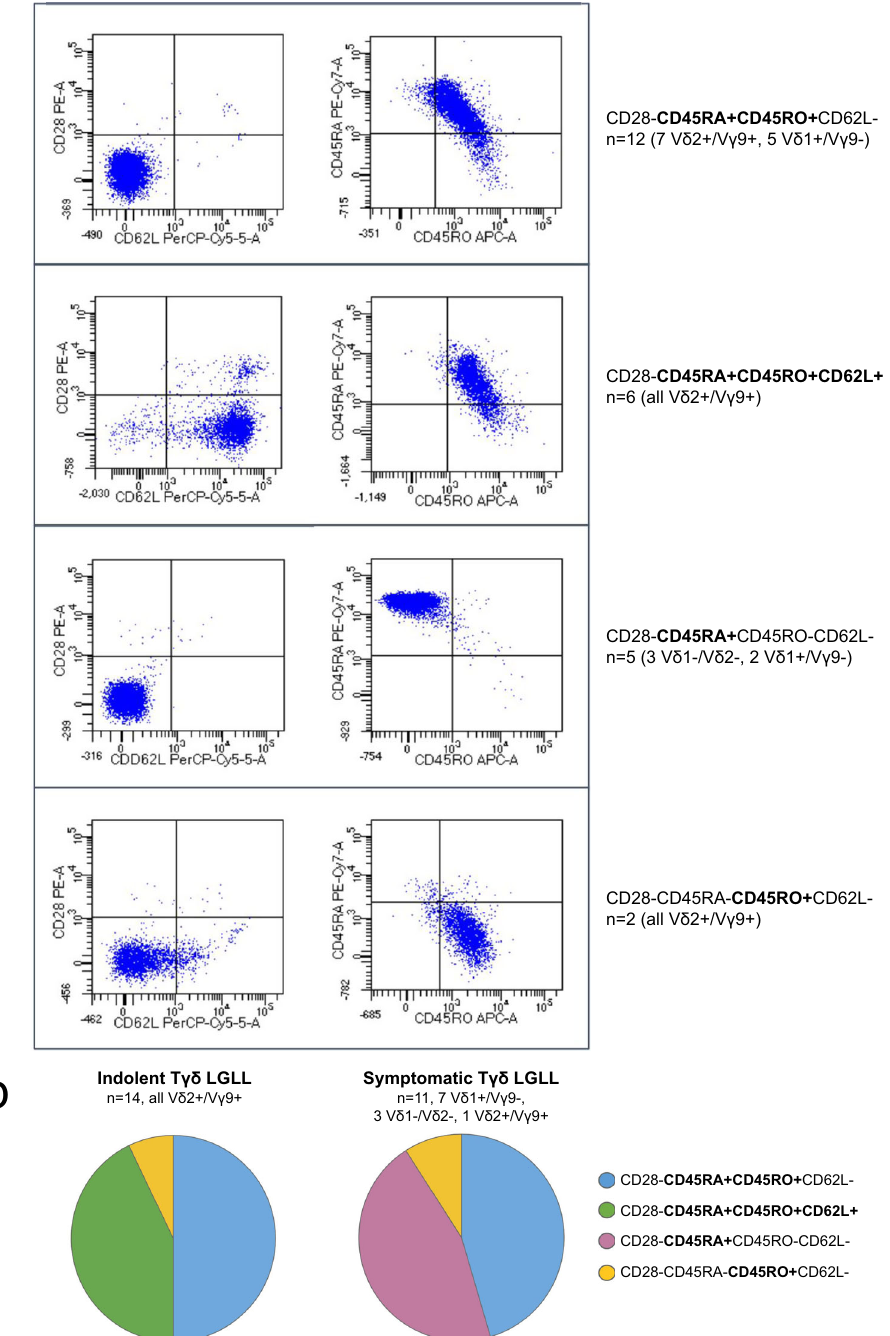
cases (pts #8 and #9) displayed low VAF compared to their clones suggesting a later onset of these mutations in clone genesis (Tables 1 and 3). Since STAT5B mutations were associated with indolent behavior in T γδ LGLL and with aggressiveness in the 3 HSTCLs (Table 2 and Supplementary Table 6), the association of STAT5B to a clinical course cannot be established.